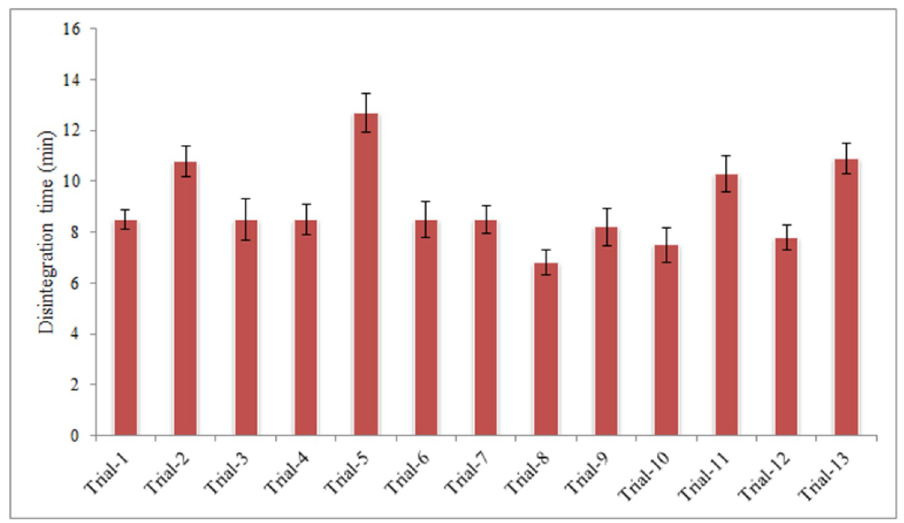
Fig 5. Disintegration time of tablets prepared from granules processed under different experimental conditions.